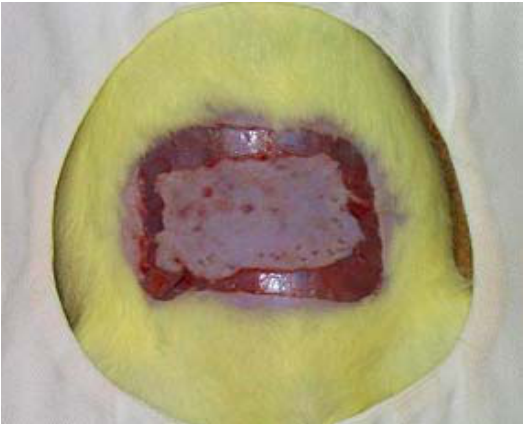
FIGURE 1: Skin incision and carneous panniculus all over circumscribed